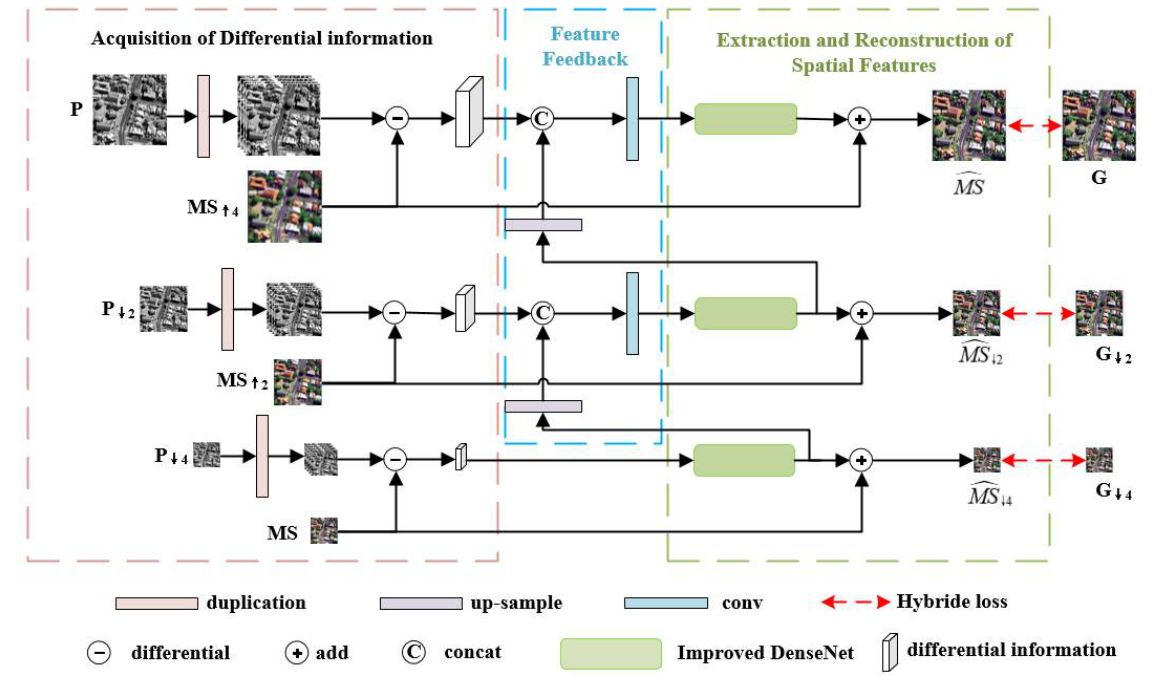
Figure 2. The framework of the proposed DS-MDNP.